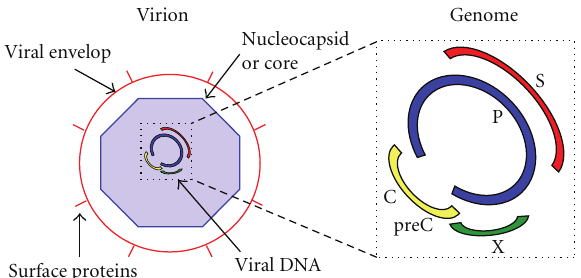
Figure 1: HBV virion and genomic organization . The HBV virion is composed of a viral envelop that contains the surface proteins, which are of di ff erent lengths (L, M, and S). The nucleocapsid or core wraps the viral DNA. The viral genome contains four open reading frames, the S that encodes for the surface protein (red), P that encodes for the viral polymerase (blue), preC and C that encode for the core (yellow) and X that encodes for the X protein